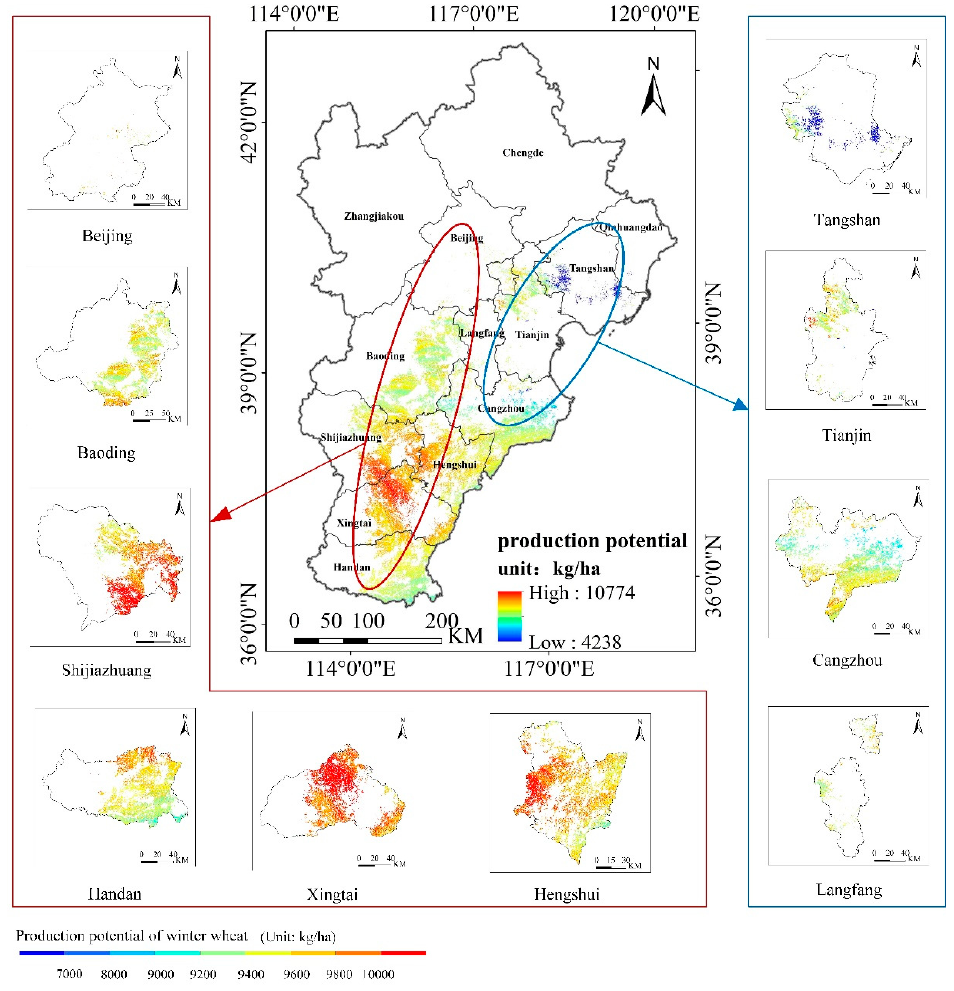
Table 7. Production potential of winter wheat in each city (unit: kg/ha).